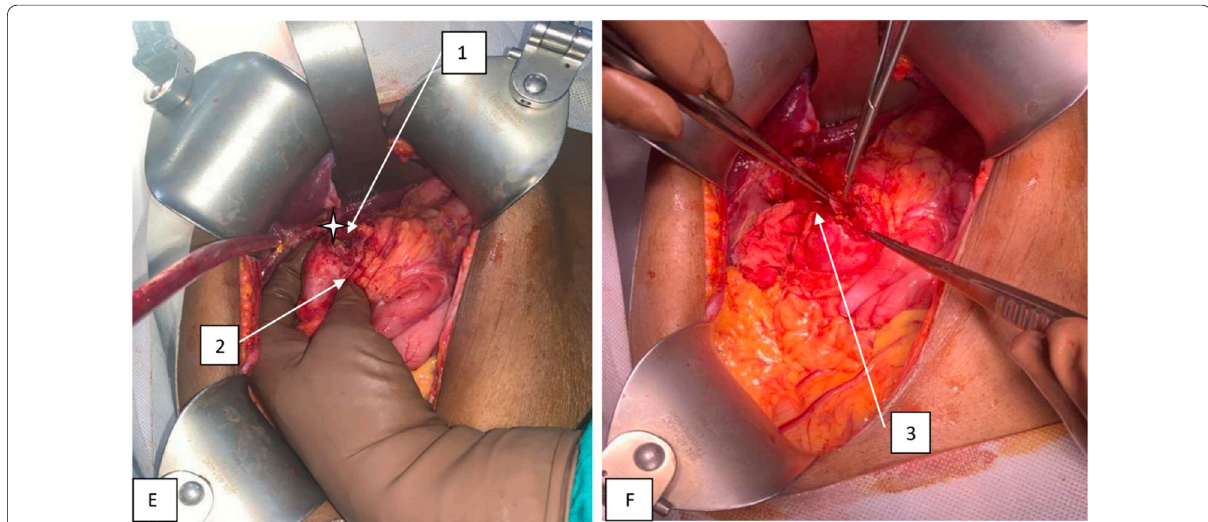
Fig. 2 E Intraoperative images showing GB fossa (star), gall stone (1) and duodenum (2). F intraoperative images after stone removal - showing fistulous opening into pylorus